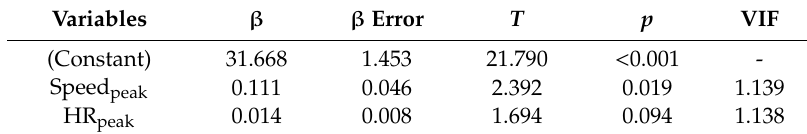
Table 4. Variables that a ff ect Peak Skin Temperature (Tsk peak ). Variables β β Error T p VIF (Constant) 31.668 1.453